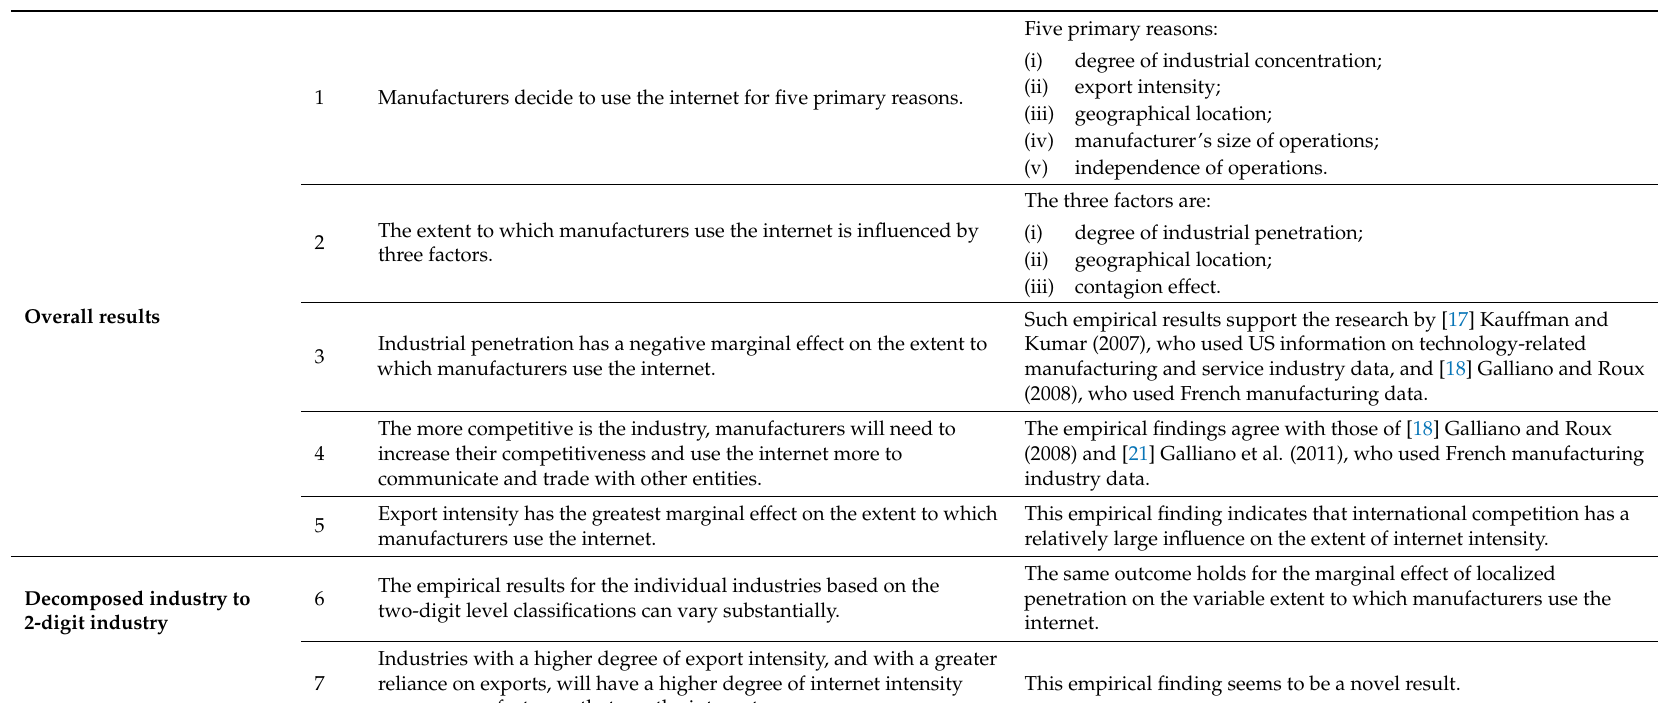
Table 10. Summary of Main